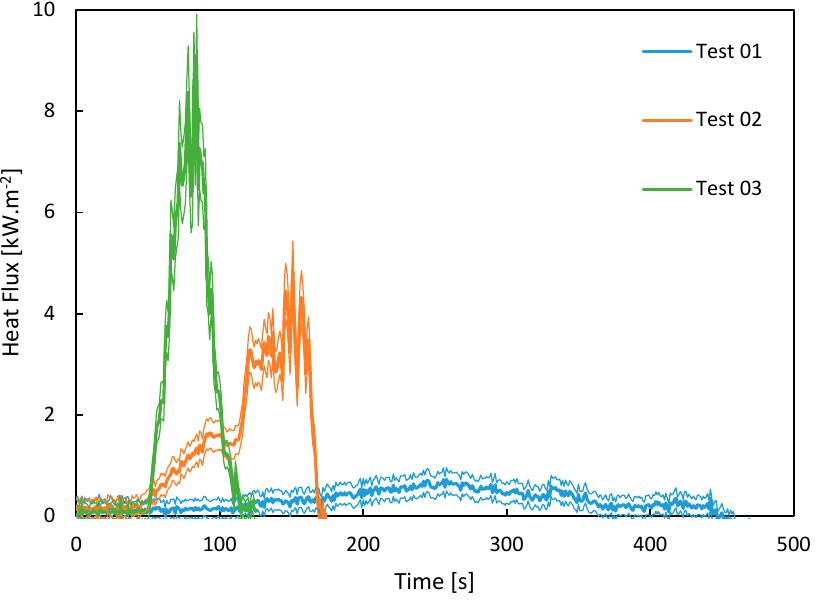
Figure 5. Evolution of heat fluxes for tests 01, 02, and 03, with different wind speeds of 0, 1, and 3 m · s − 1 ,